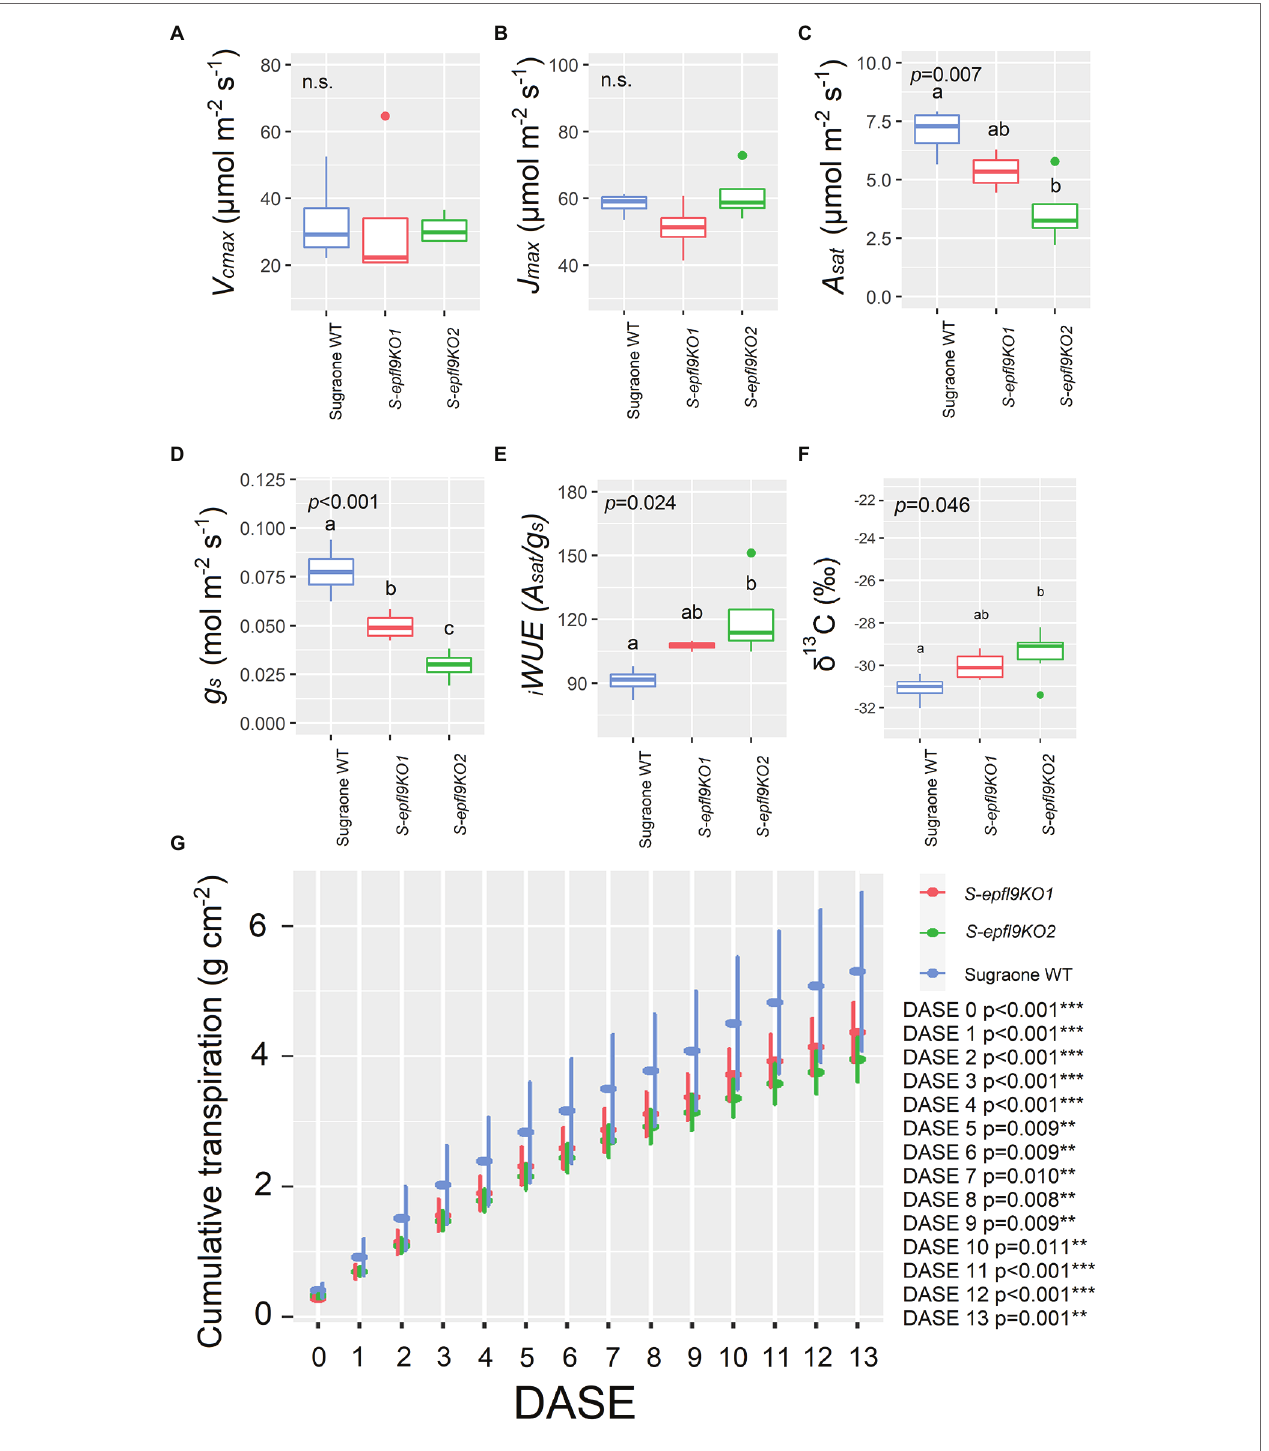
FIGURE 5 | Trait assessment under well-watered (WW) conditions (Experiment 1). (A) Maximum velocity of Rubisco carboxylation ( V cmax ). (B) Maximum electron transport rate for RuBP regeneration ( J max ) estimated with A/C i curves and following curve fitting (Duursma, 2015; Easlon and Bloom, 2014). (C) CO 2 assimilation rate at saturating light ( A sat ). (D) Stomatal conductance ( g s ) extrapolated from A/C i curves at 400 ppm CO 2 concentration and 1,500 μ mol m − 2 s − 1 . (E) Intrinsic water-use efficiency ( i WUE ) calculated as i WUE = A sat / g s . (F) Carbon Isotope composition ( δ 13 C) analysis. Data were collected on fully expanded leaves of 20 cm tall plants on the twelfth day from the start of the experiment and were elaborated with one-way ANOVA ( n = 4 in A – E ; n = 3–6 in F ). Whiskers indicate the ranges of the minimum and maximum values and different letters indicate significantly different values according to Fisher’s test. (G) Cumulative water loss assessed gravimetrically and normalized for leaf area estimated via RGB imaging for a period of 14 days; DASE = Days After Start of the Experiment. Data were means ± standard error of the mean ( n = 5–6). Data were elaborated with one- way ANOVA for each day (*** p < 0.001, ** p < 0.01, * p < 0.05). When present, different letters indicate significantly different values according to Fisher’s